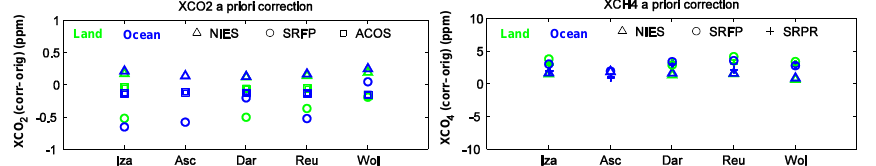
Figure 2. The average of the differences between a priori-corrected and original satellite XCO 2 and XCH 4 retrievals (corrected – original) at five TCCON stations. Iza, Asc, Dar, Reu and Wol stand for Izaña, Ascension Island, Darwin, Reunion Island and Wollongong. The blue footprints are sun glint data over ocean and the green ones are data above